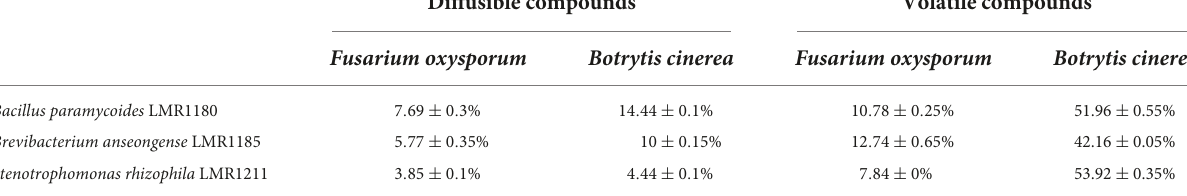
TABLE 1 Effects of the three selected strains ( Bacillus paramycoides LMR1180, Brevibacterium anseongense LMR1185, and Stenotrophomonas rhizophila LMR1211) on the radial growth of two fungi ( Botrytis cinerea and Fusarium oxysporum ). Diffusible compounds Volatile compounds Fusarium oxysporum Botrytis cinerea Fusarium oxysporum Botrytis